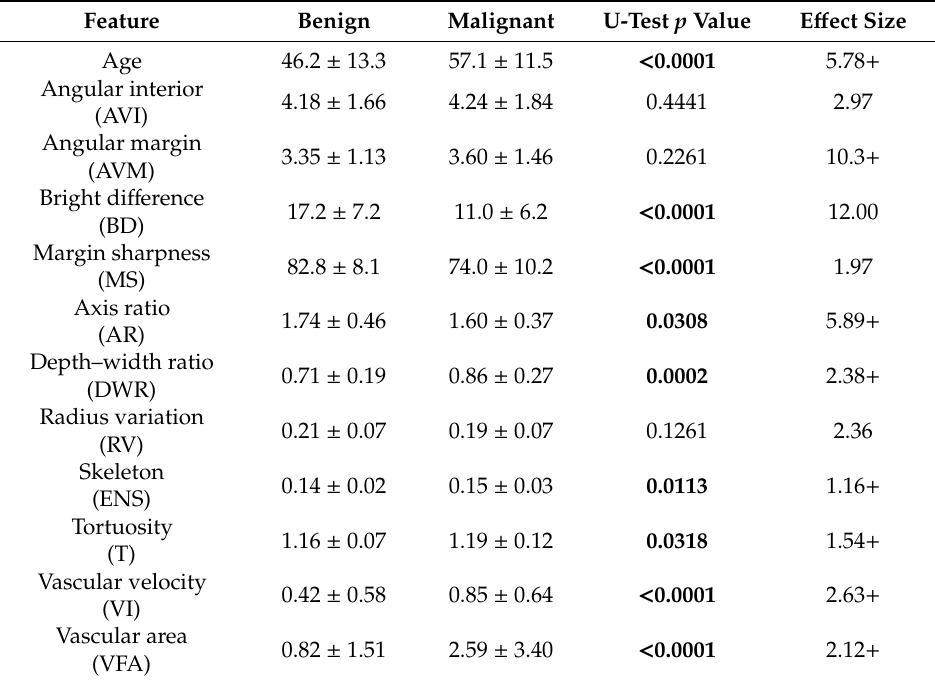
Table 1. Numeric feature distribution, significance, and e ff ect size.